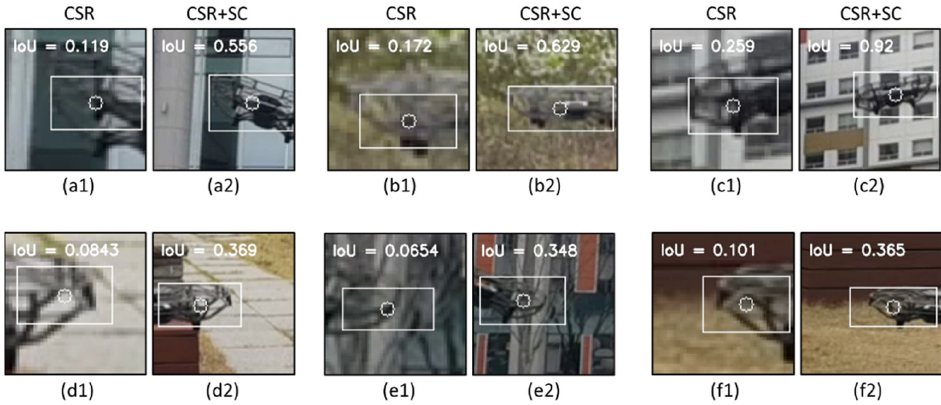
Figure 6. Effects of SC on the truncation in SRs. ( a1 – f1 ) represent the SR of the CSR tracker; ( a2 – f2 ) show the SR when truncation preventive SR is applied.